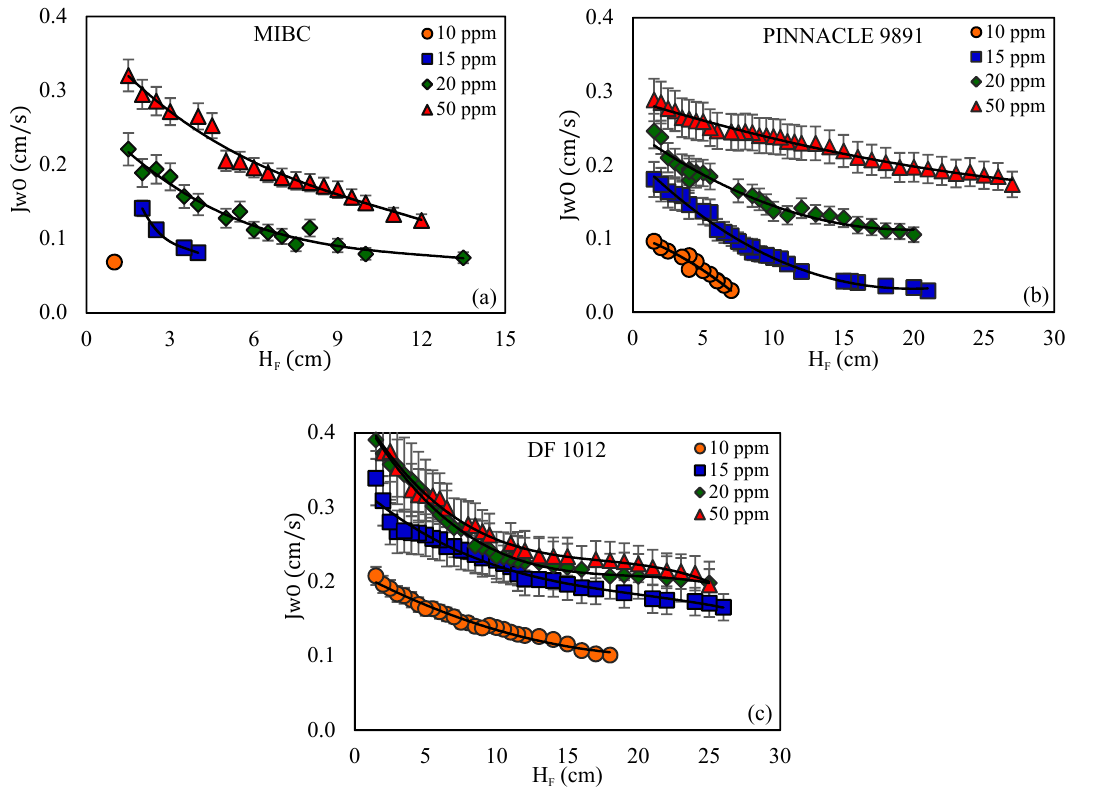
Figure 4. Water overflow rate as a function of froth depth for: ( a ) MIBC, ( b ) PINNACLE 9891 and ( c ) DF 1012 and Jg = 1.6 cm/s.